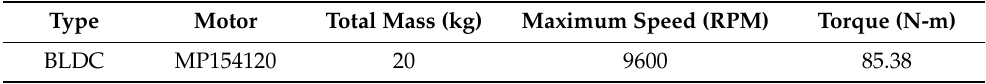
Table 8. Motor performance